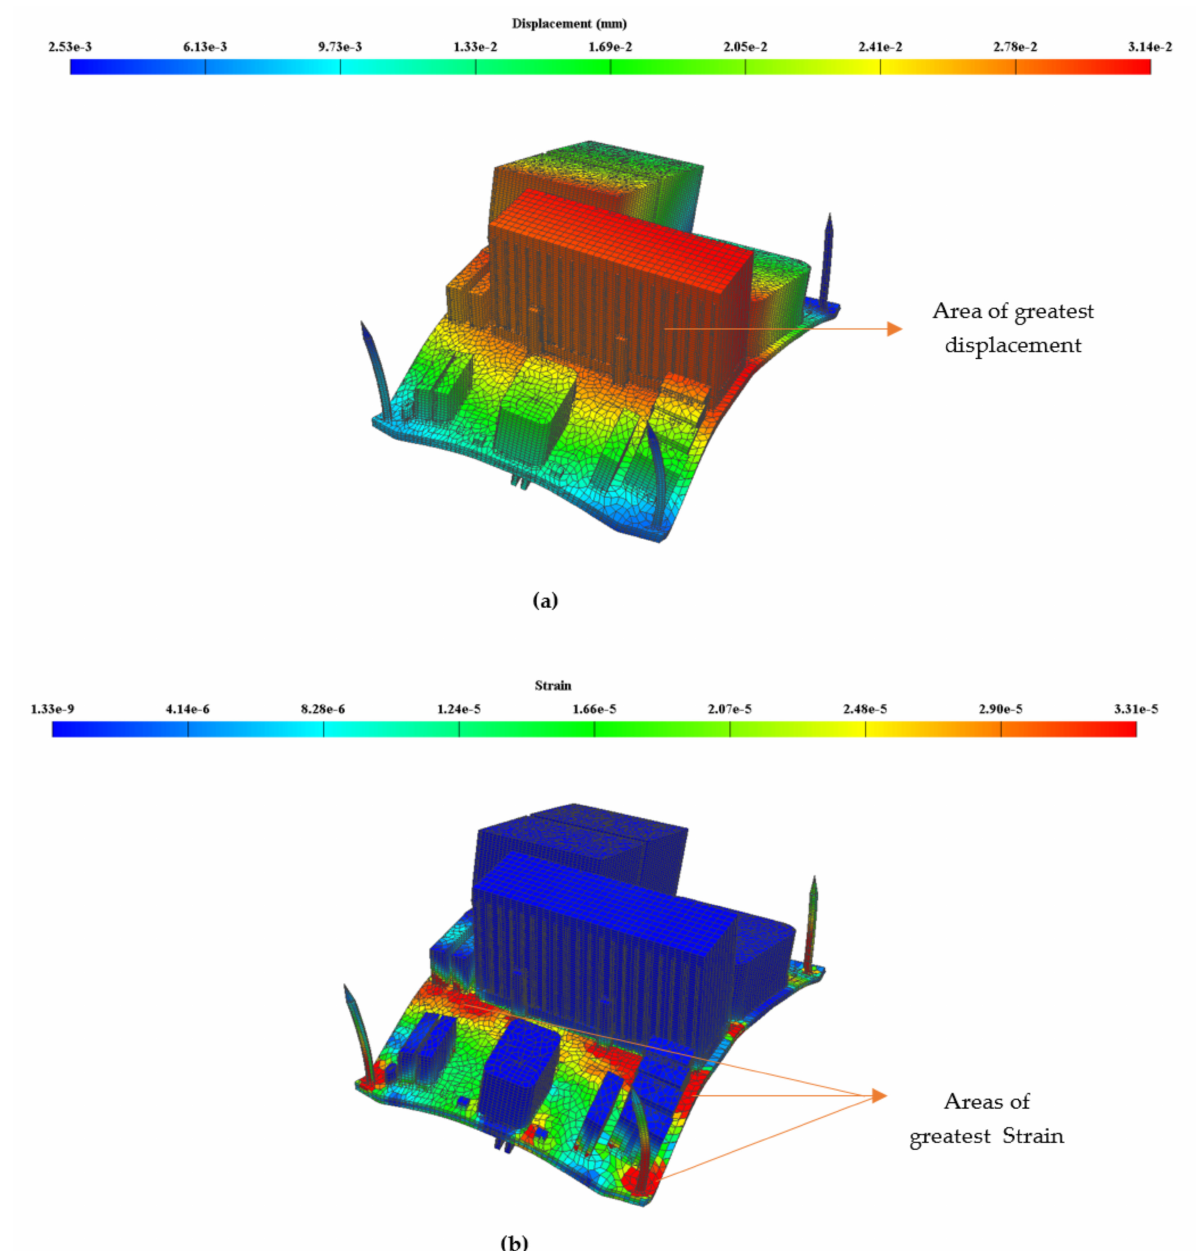
Figure 10. ( a ) Displacement due to harmonic loading at 73.98 Hz. ( b ) Strain due to harmonic loading at 73.98